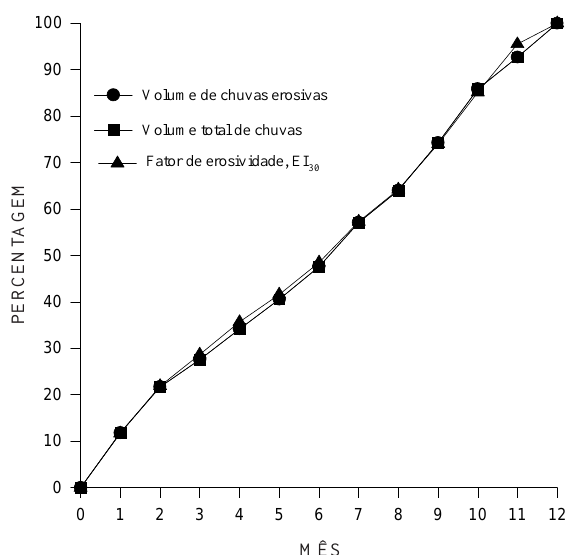
Figura 1. Curvas de distribuição do volume das chuvas erosivas e total e do fator de erosividade, EI , obtidos no período de 1989 a 30 1998 em Lages (SC). (Os meses 0, 1, 2, 3, 4, 5, 6, 7, 8, 9, 10, 11 e 12 equivalem às datas 1/jan., 1/fev., 1/mar., 1/abr., 1/maio, 1/jun., 1/jul., 1/ago., 1/set., 1/out., 1/nov., 1/dez e 1/jan.,